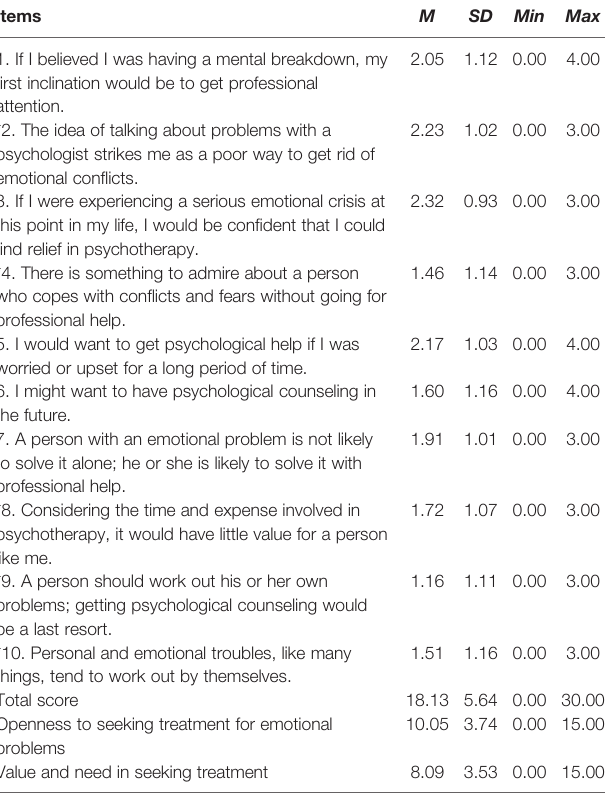
TABLE 2 | Scores on the attitude toward seeking professional psychological help scale-short form (ATSPPH-SF). Items M SD Min